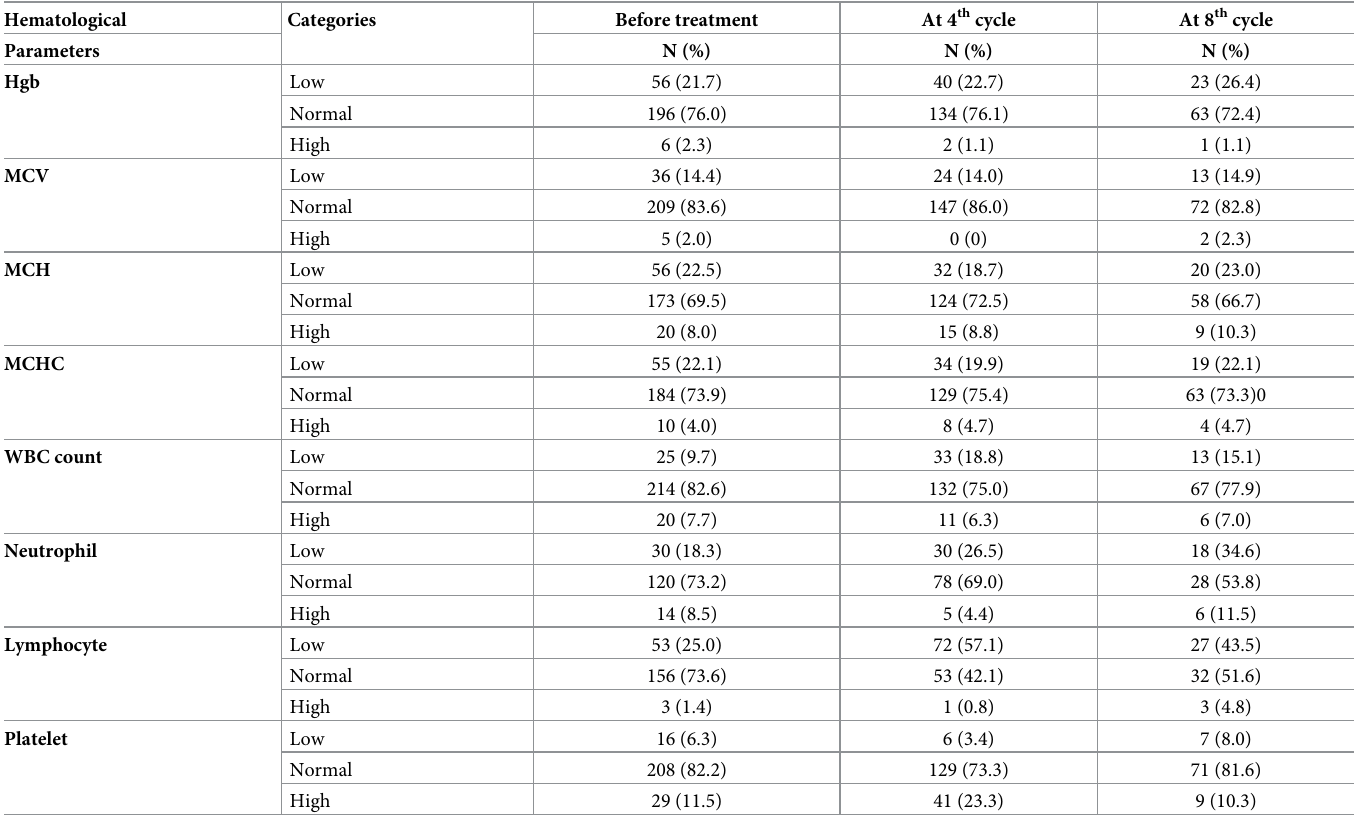
Table 4. Hematological parameters of breast cancer patients at UoG-SCH cancer treatment center, Northwest Ethiopia, 2021.